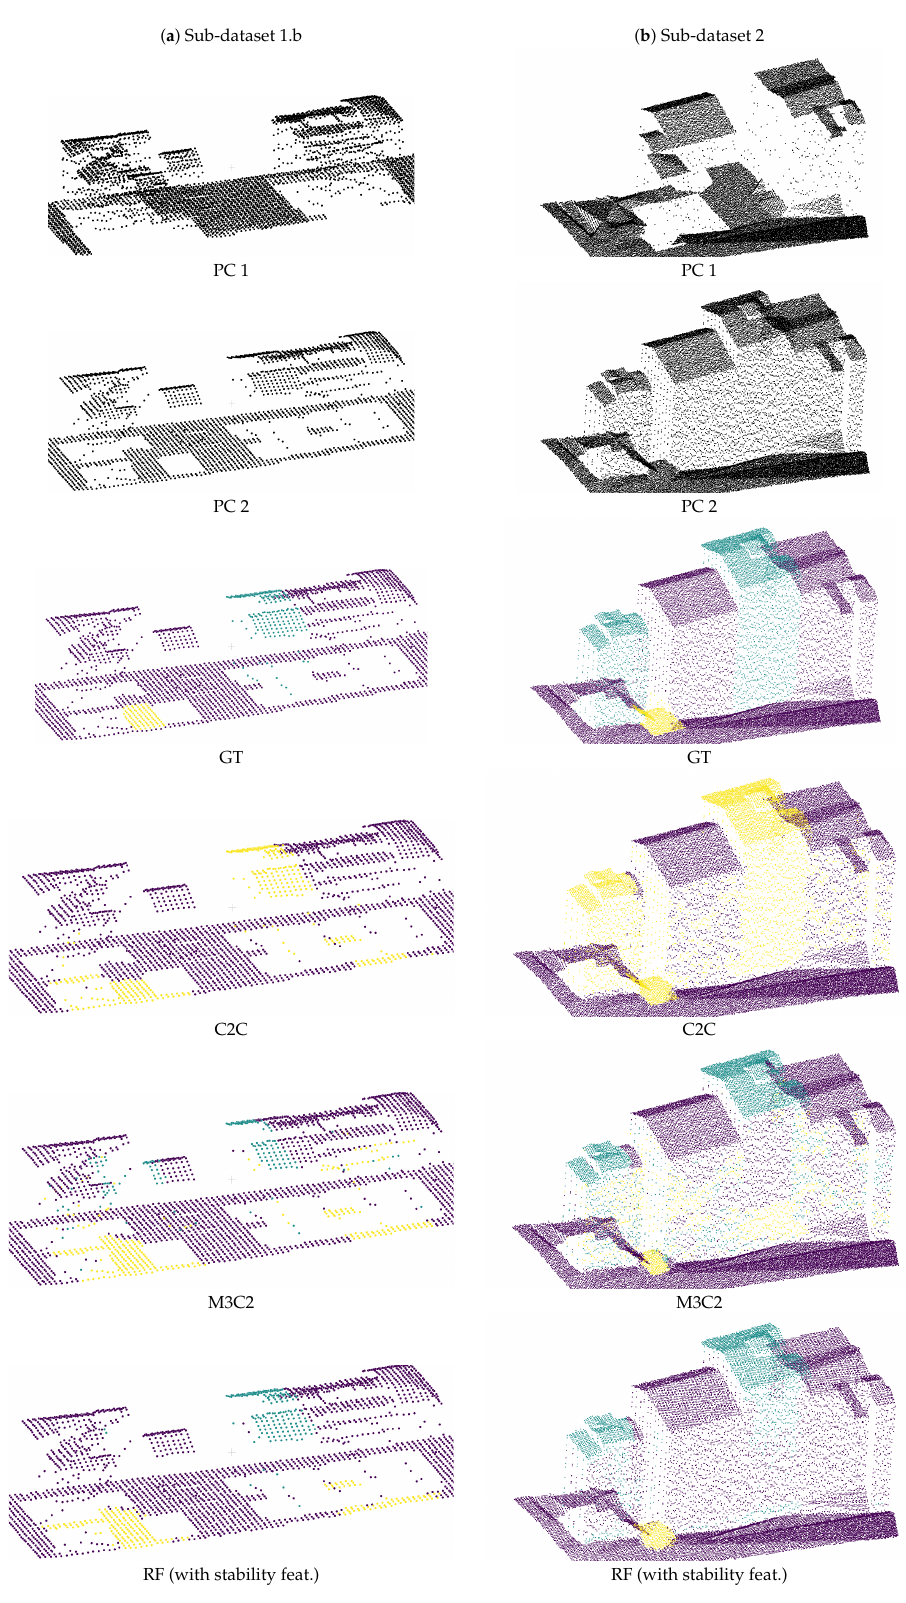
Figure 12. Results on PCs for methods at 3D point level for sub-datasets 1.b ( a ) and 2 ( b ). Both PCs corresponding to both dates are given. The corresponding ground truth (GT) indicates changes in the second PC (PC 2) compared to the previous PC (PC 1): purple for unchanged areas, blue for new construction areas and yellow for demolition areas. The same colors are used for M3C2 and RF with hand-crafted features. C2C results are only binary: purple corresponds to unchanged parts and yellow to changed